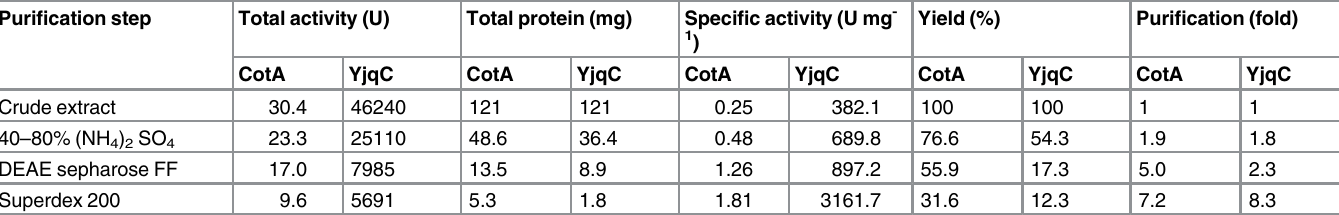
Table 3. Purification of YjqC and CotA from B . altitudinis SYBC hb4 spores.